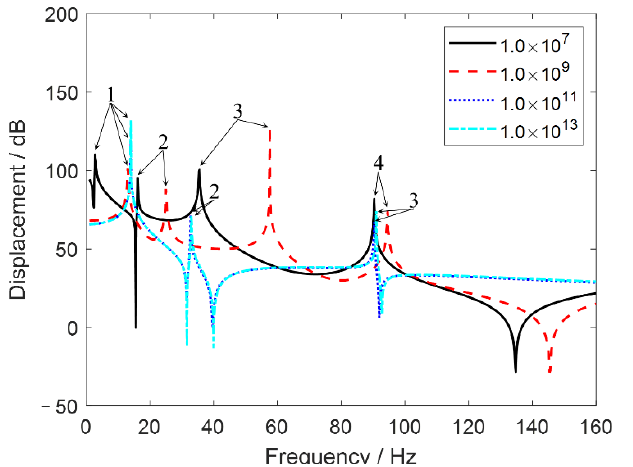
Figure 5. Transverse vibration response under different bearings stiffness. The location of the response point is x = 0 m. Numbers and arrows are used to mark the order of the resonance.